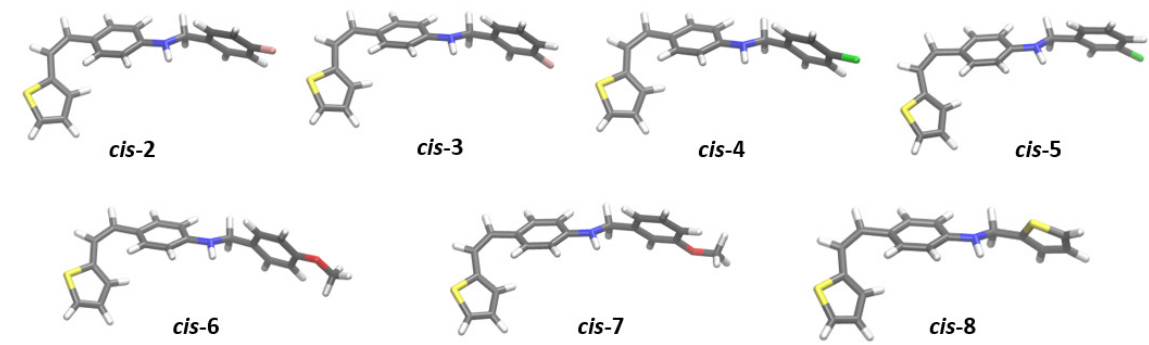
Figure 6. The most stable conformers of cis -isomers of styryl-thiophene benzylamines 2 – 8 , optimized at the M06-2X/6-31g(d) level of theory.